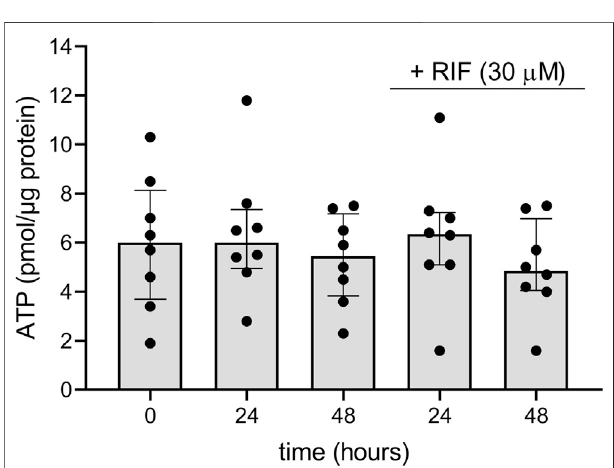
FIGURE 2 | ATP contents in freshly prepared hPCISs (0 h) and after incubation in WME for 24 and 48 h with or without RIF (30 µM). Presented data are medians calculated from eight donors with interquartile ranges. Dots represent individual donor ’ s values. No signi fi cant differences between RIF-free and RIF-treated samples were detected by the nonparametric Kruskal – Wallis analysis followed by Dunn ’ s